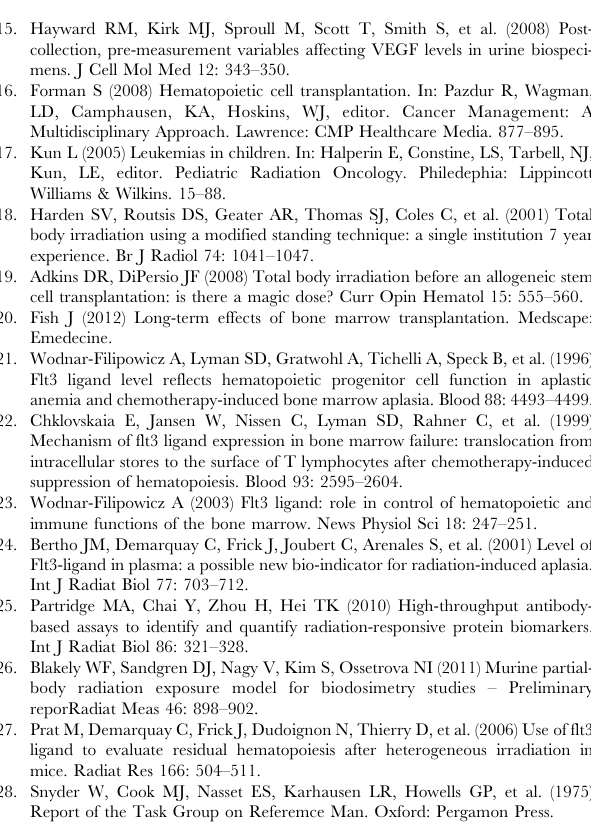
Table S1 Results of Potential Processing Variables Relevant to Clinical Screening of